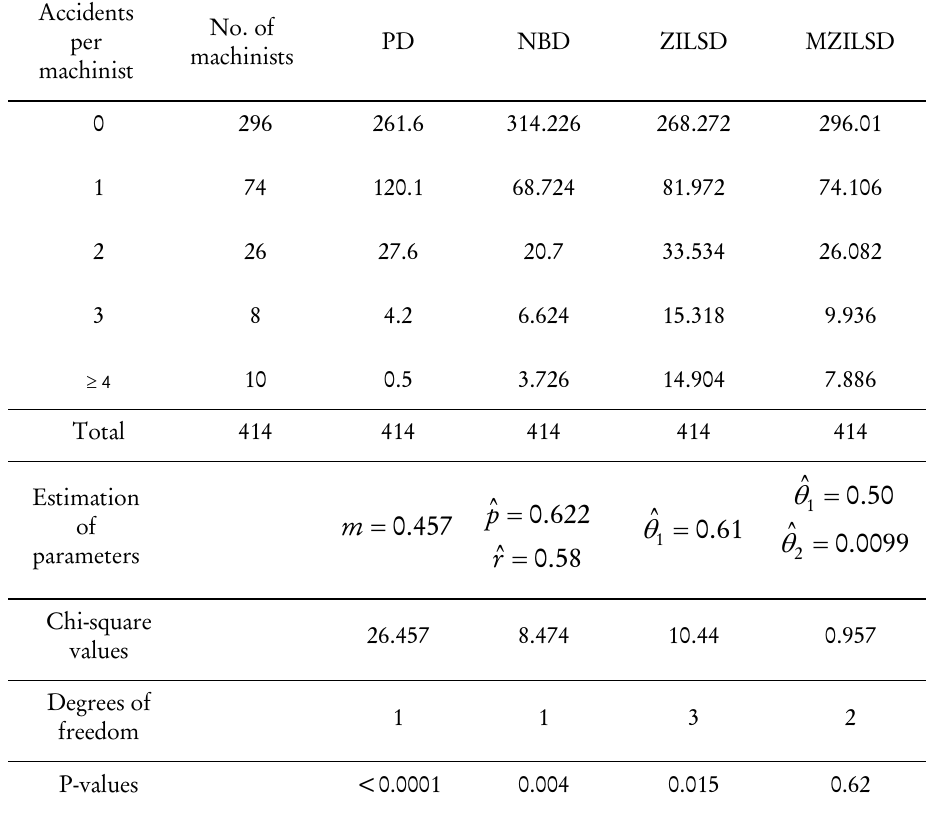
Observed frequencies and computed values of expected frequencies of the PD, the NBD, the ZLSD and the MZILSD by method of maximum likelihood for the second data